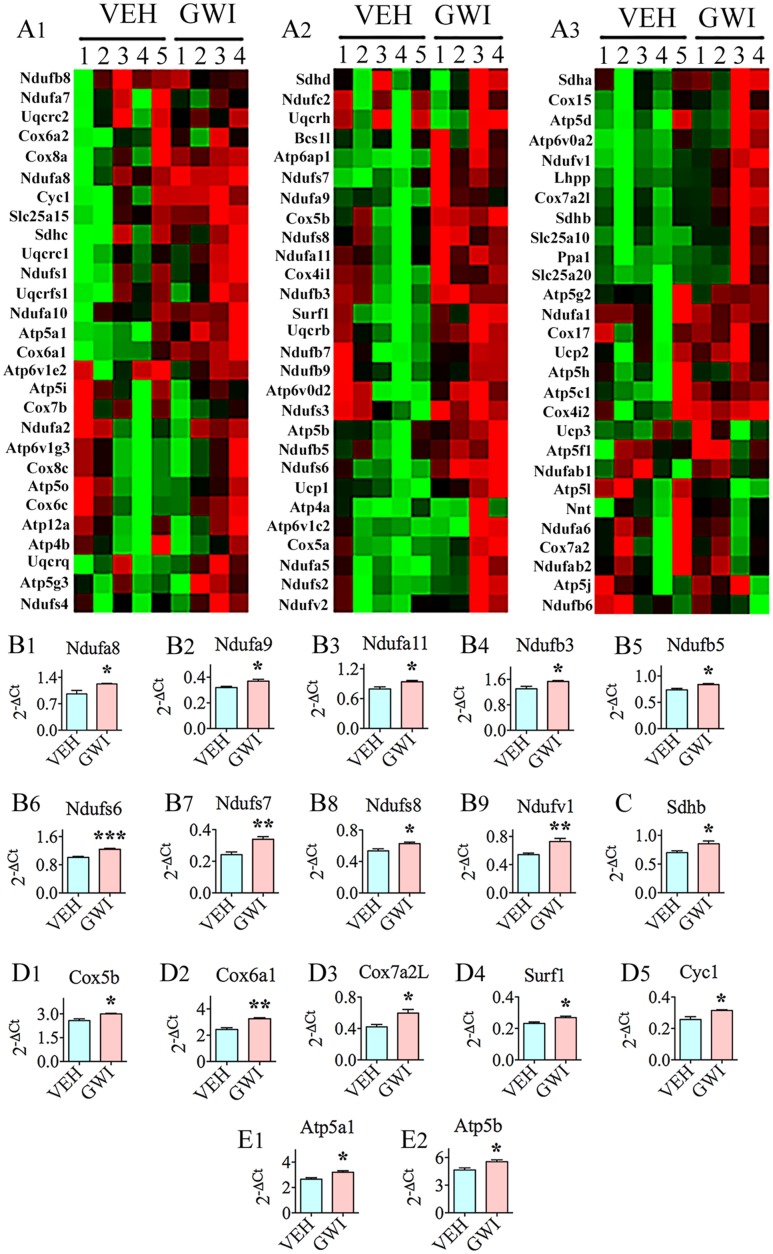
The hippocampus of rats with chronic gulf war illness-like symptoms (GWI-rats) presented an increased expression of multiple genes (n = 26) involved in mitochondrial respiration. (A,C) Are cluster diagrams comparing the relative expression of mitochondria-related genes between animals exposed to vehicle (n = 5), GWI-related chemicals (GWIR-Cs), and stress (n = 4), which was measured 6 months after exposure using quantitative real-time polymerase chain reaction. Bar charts in B1–B9,C,D1–D5,E1,E2 illustrate the elevated expression of genes involved in mitochondrial complex I (Ndufa8, Ndufa9, Ndufa11, Ndufb3, Ndufb5, Ndufs6, Ndufs7, Ndufs8, and Ndufv1; B1–B9), complex II (Sdhb; C), complex IV (Cox5b, Cox6a1, Cox7a2L, Surf1, and Cyc1; D1–D5), and complex V (Atp5a1 and Atp5b; E1,E2) of GWI-rats. ∗p < 0.05; ∗∗p < 0.01; ∗∗∗p < 0.001.